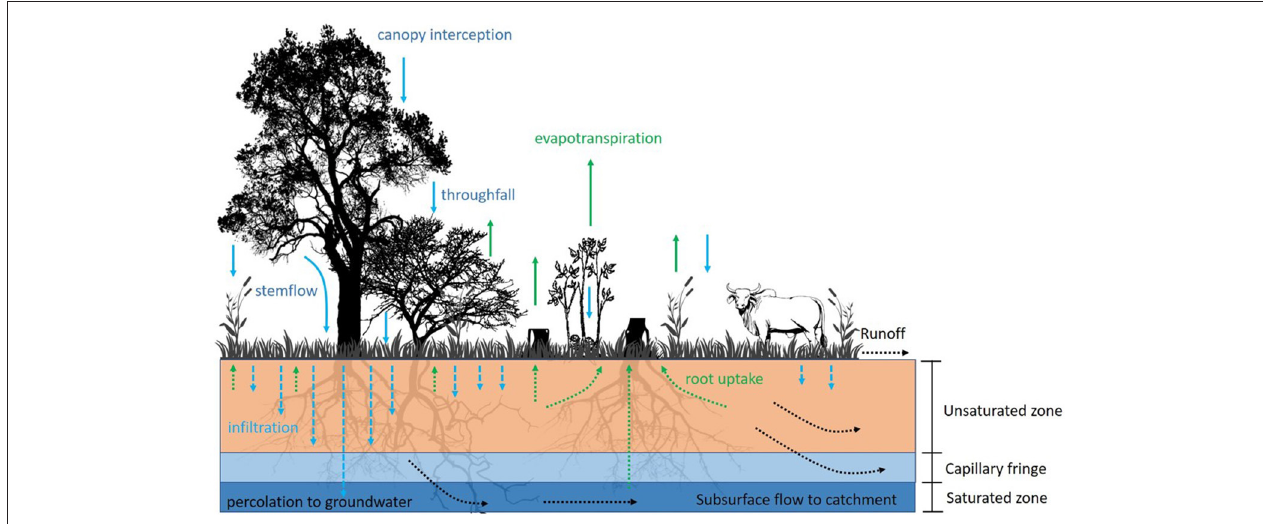
FIGURE 2 | Hydrological processes most relevant for exploring the effects of charcoal production and livestock on hydrological functioning. Illustration by